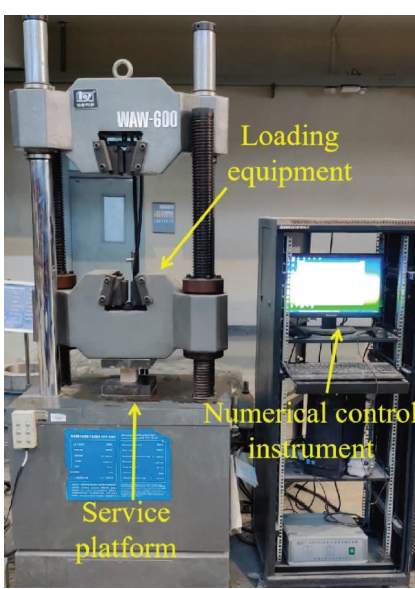
Figure 5: Microcomputer servo pressure testing